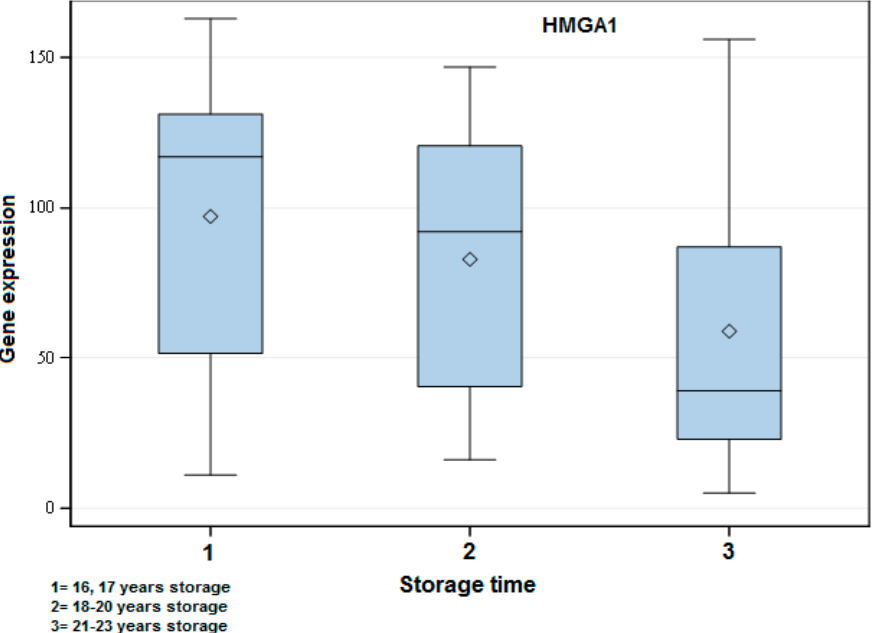
Figure 2. Exemplary box-plot figure showing the gene expression of HMGA1 when comparing the different storage time groups of FFPE samples. The years of storage are indicated in the figure. There was a significant difference among all groups: 1 vs. 2 ( p < 0.05), 1 vs. 3 ( p < 0.001) and 2 vs. 3 ( p < 0.01). A higher gene expression in the short storage time group followed by Groups 2 and 3 could be observed.